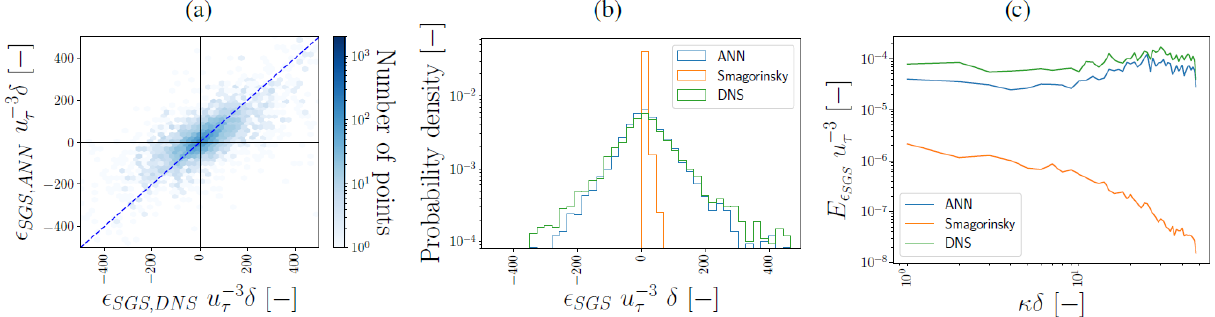
( 64 . 53125 z + ) ) for a representative flow field not used Figure 9. Performance of (cid:15) SGS , ANN (with n hidden = 64) in the log layer (0 . 109375 z δ to train and validate the ANNs. Panel (a) shows the corresponding hexbin plot between (cid:15) SGS , ANN and (cid:15) SGS , DNS , where the dotted blue line indicates the 1 : 1 line. Panel (b) shows the probability density functions and panel (c) the stream-wise spectra averaged in the span-wise direction. (cid:15) SGS , ANN and (cid:15) SGS , DNS have been normalized by the friction velocity u − 3 τ and δ . The power spectral density E on the vertical axis in panel (c) has been normalized by u τ − 3 . As a reference, in panels (b) and (c) , (cid:15) SGS , Smag is shown as well.